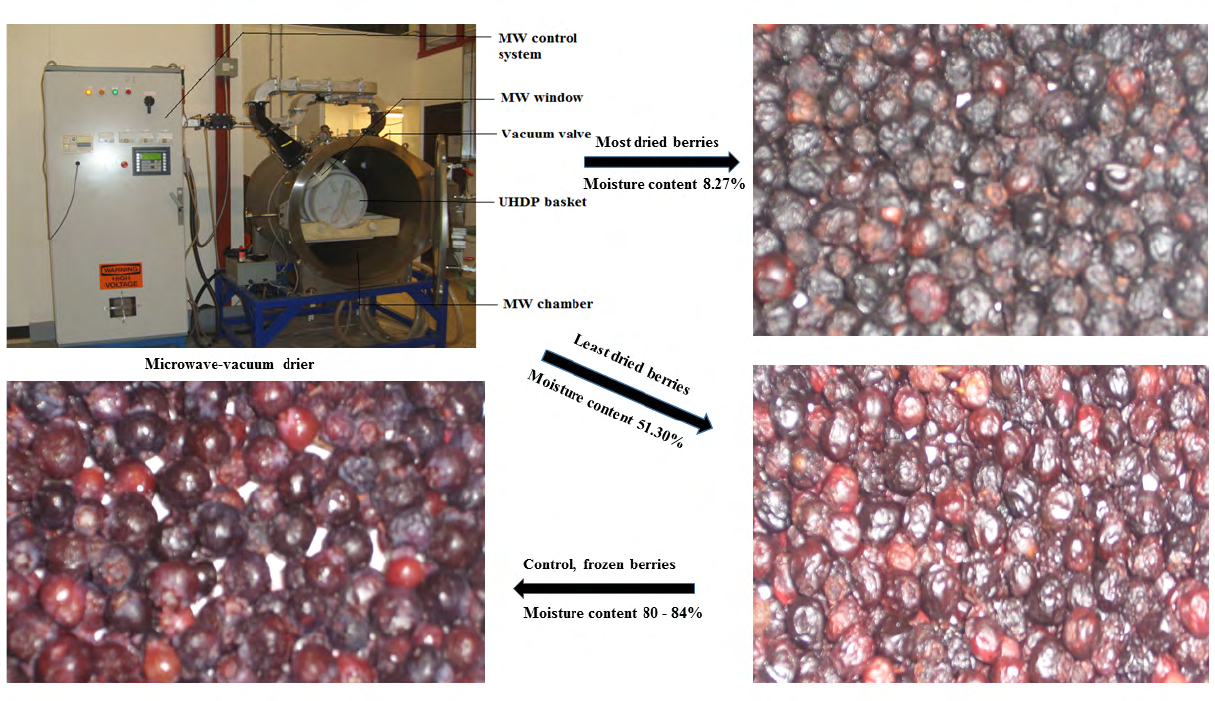
Figure 1 Microwave-vacuum drier used in the study and control (frozen), least dried and most dried Saskatoon berries